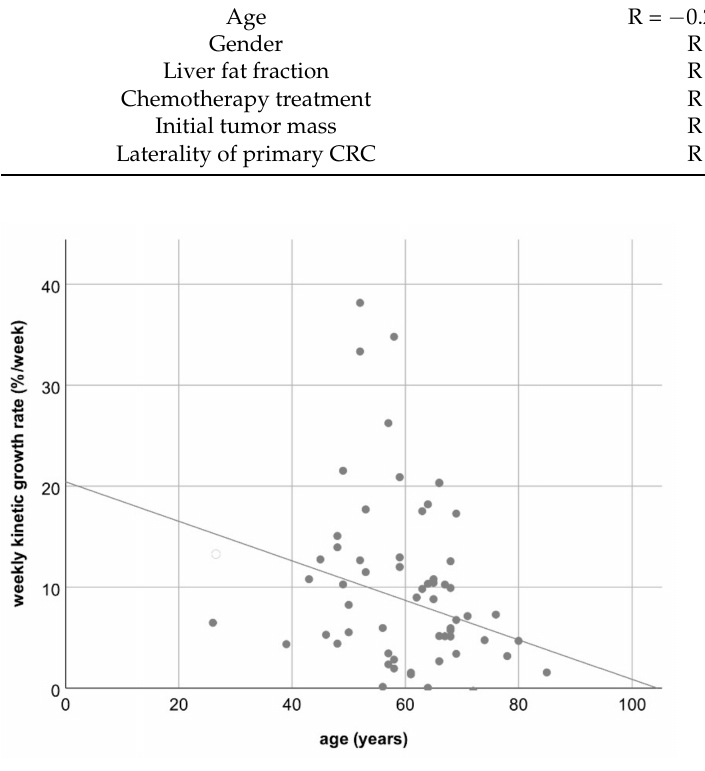
Figure 5. Scatterplot C: Loose inverse correlation between the patient’s age and the weekly kinetic growth rate; R = − 0.24 ( p =